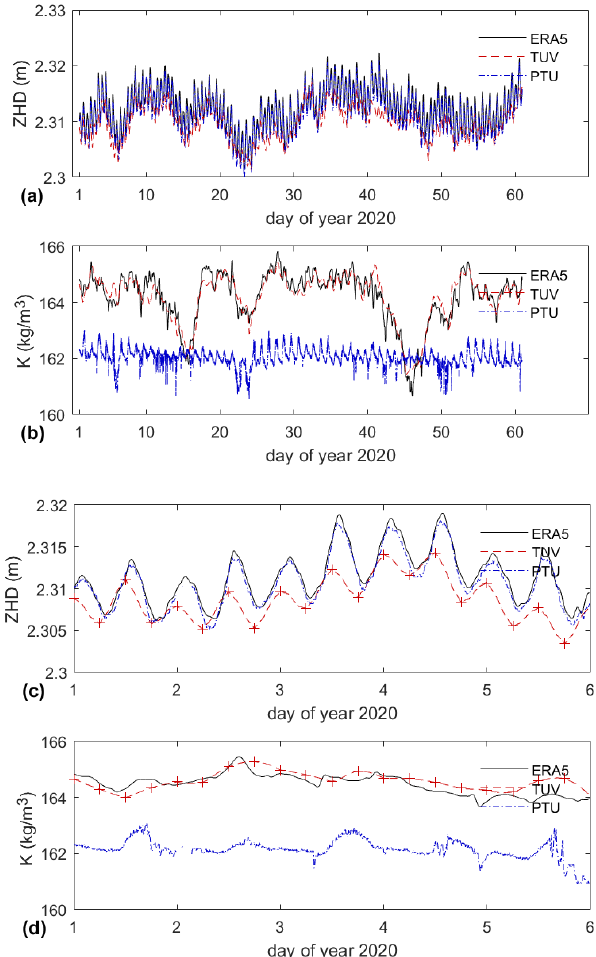
Figure 2. Time series of the auxiliary data (ZHD and K ) used to convert ZTD to IWV in the different GNSS streams: high-resolution ERA5 pressure-level data, ECMWF analysis provided by TUV, sur- face pressure and temperature observations (PTU) for GNSS station BCON (a, b) from 1 January to 29 February 2020 and (c, d) from